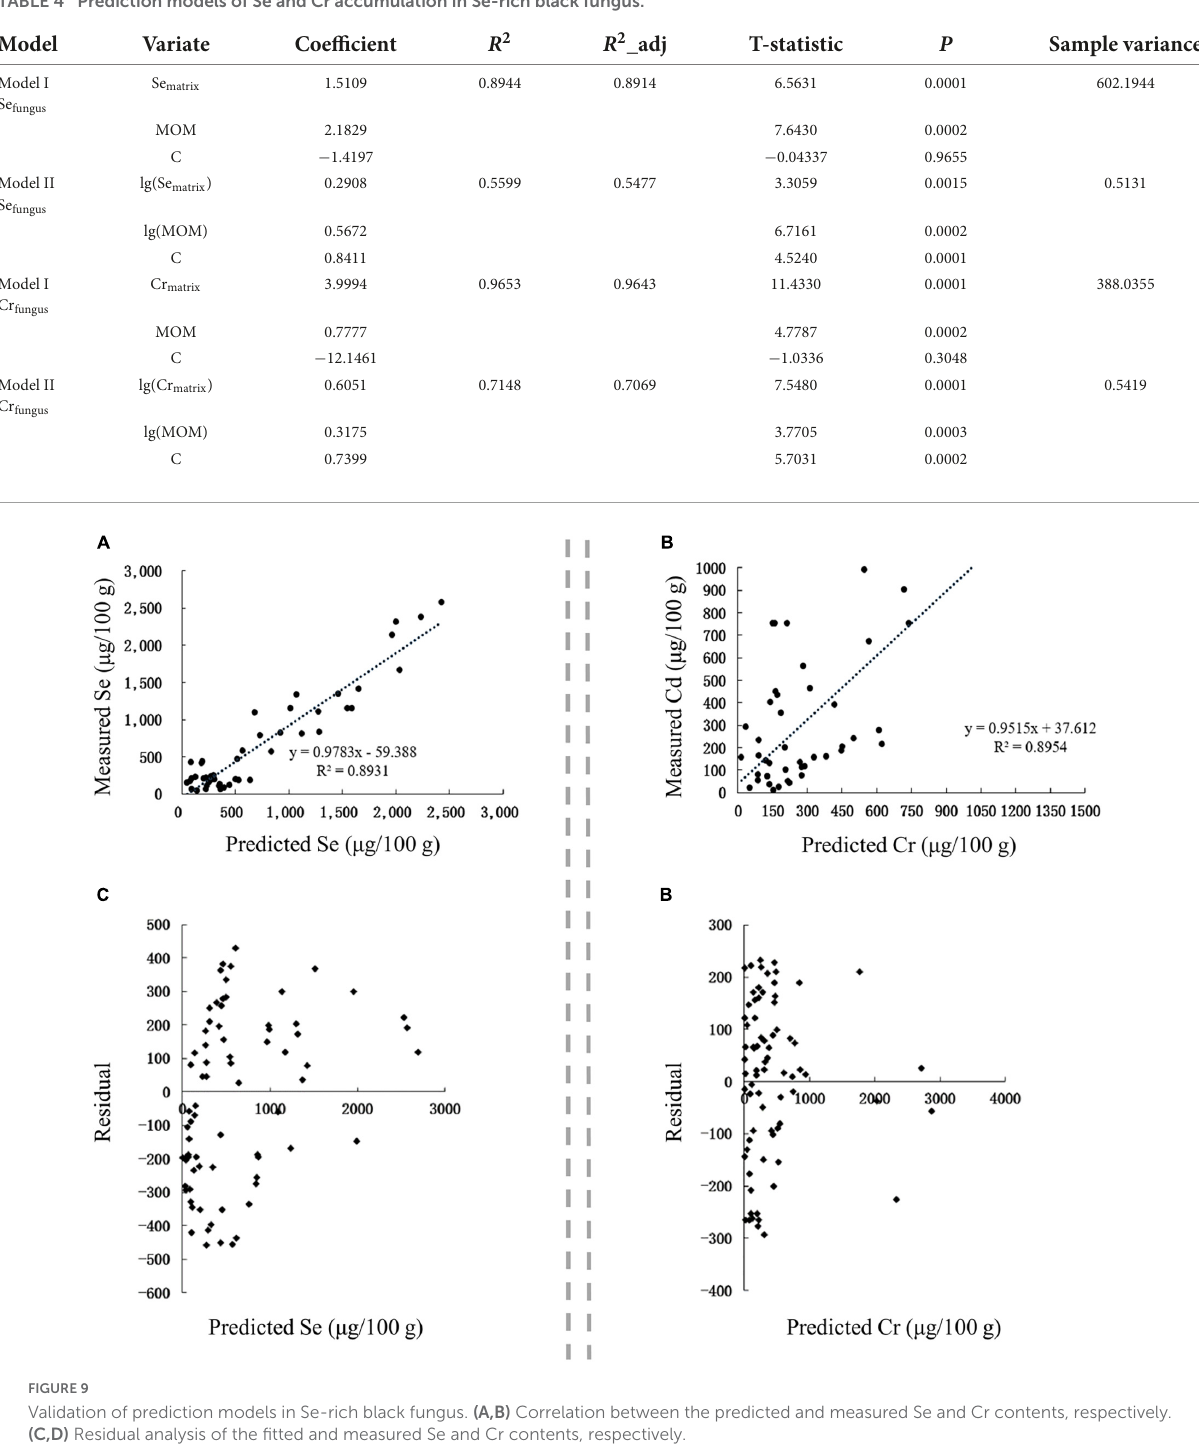
TABLE 4 Prediction models of Se and Cr accumulation in Se-rich black fungus.